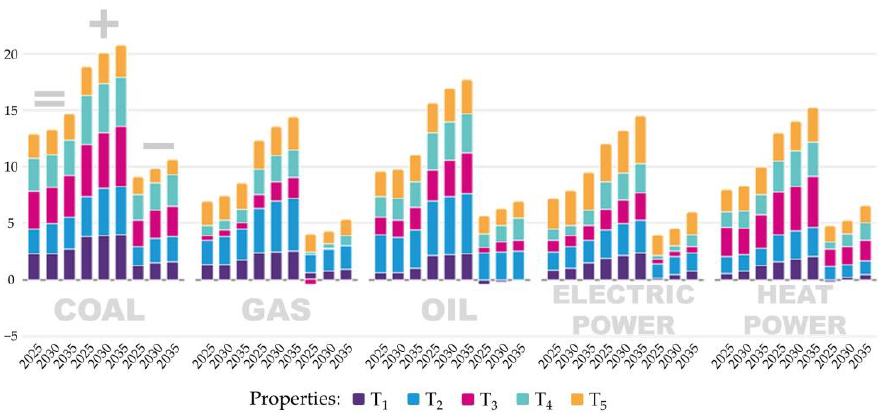
Figure 10. Industry’s scenario coefficients of the development of properties of the Siberian LFEC at three time intervals.